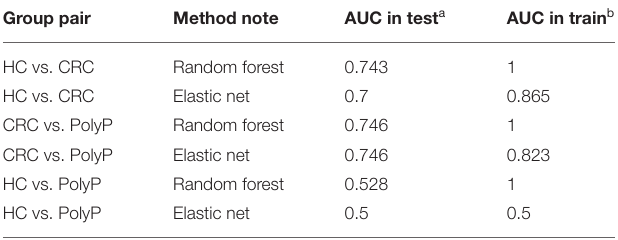
TABLE 2 | AUC of ROC in the test set and train set for pair group